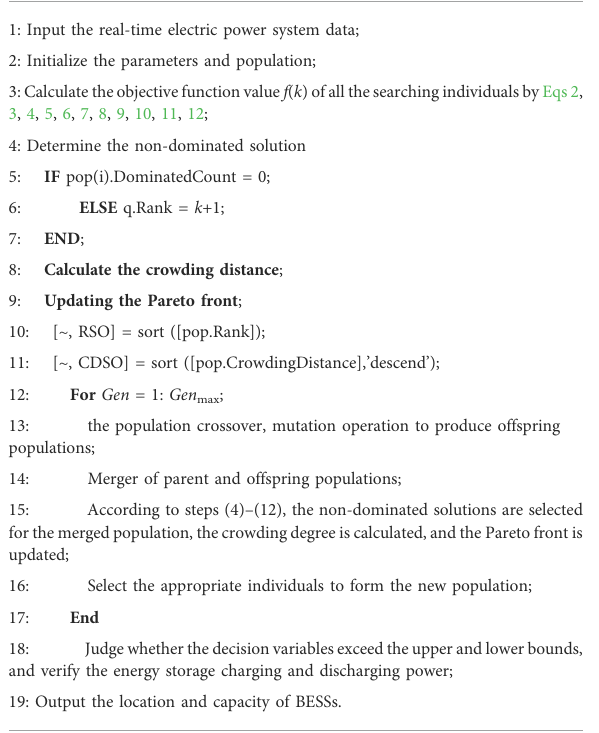
TABLE 1 The basic principles and procedures of NSGA-II.